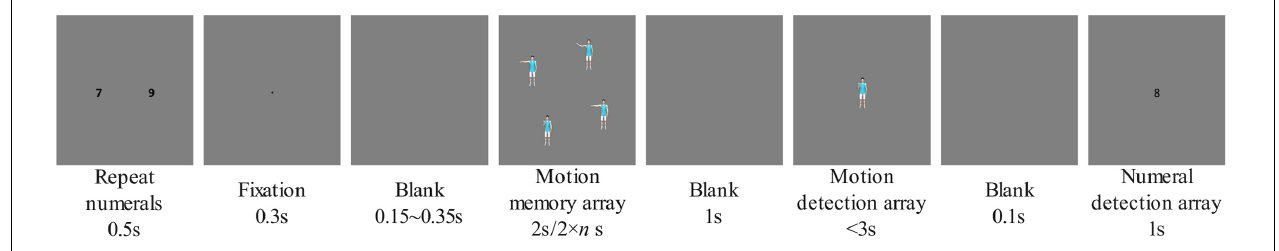
FIGURE 2 | Experiment process. With set size = 4 shown as an